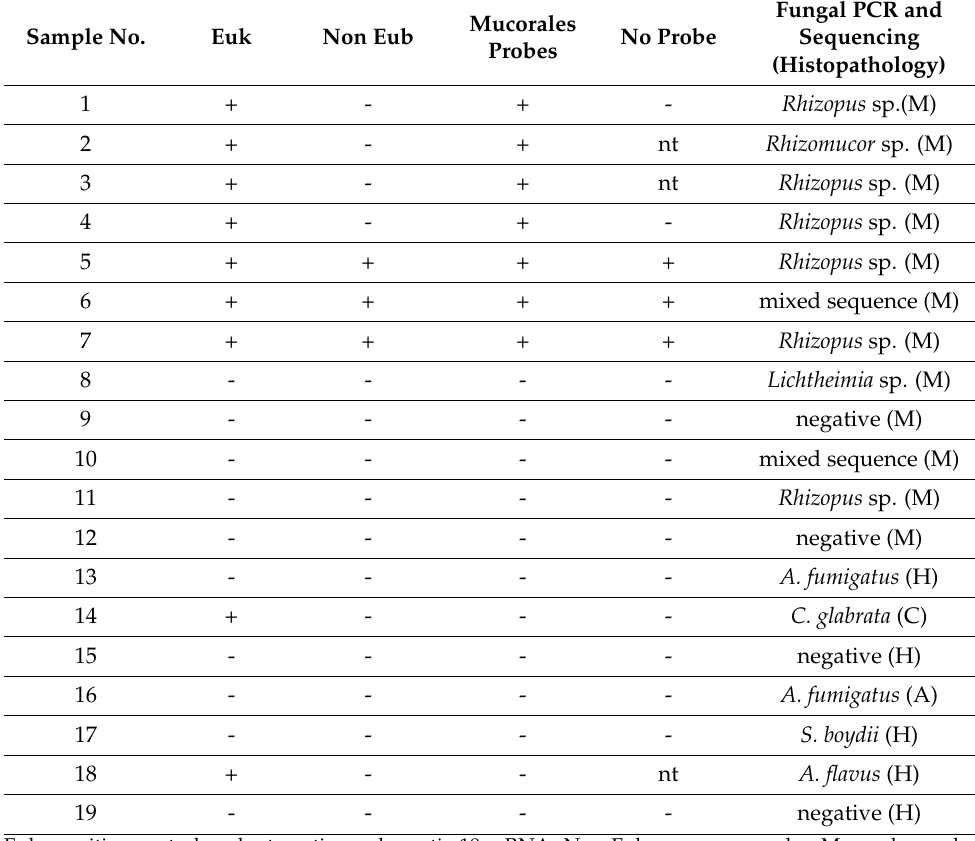
Table 2. Formalin-fixed, paraffin-embedded tissue samples from patients with proven fungal infection as diagnosed by histopathology and broad-range fungal qPCR.